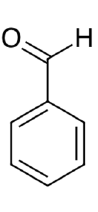
Figure 1. Structure of the benzaldehyde tested in this study.